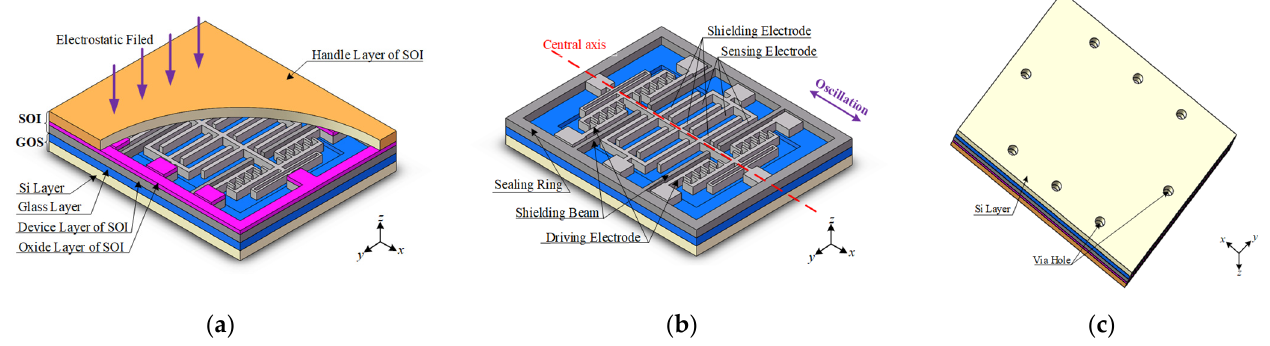
Figure 1. ( a ) Top view of the WLVP structure of the microsensor; ( b ) detailed view of the device layer of SOI; ( c ) bottom view of the WLVP structure of the microsensor.